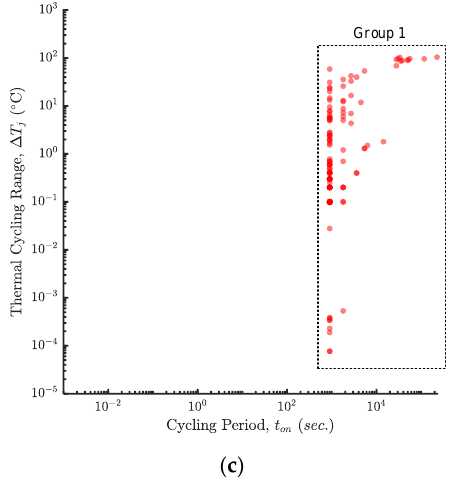
Figure 13. Rainflow-counting results of the diode junction temperature profile for ( a ) 7-day com- plete peak – valley profile, ( b ) 7-day reduced peak – valley profile, and ( c ) 7-day averaged peak – valley profile.